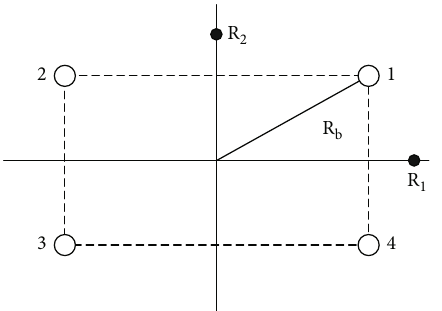
Figure 8: Grouting holes are arranged along the top of the